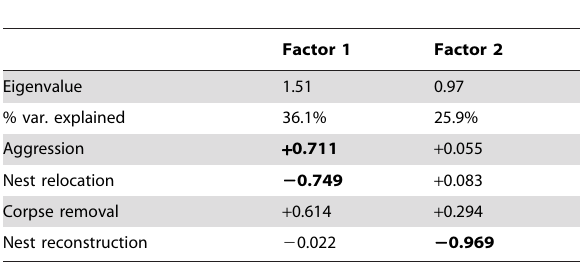
Table 2. Results of the two first factors of the factor analysis performed on mean behaviors of two trials after applying a Z- score transformation and a varimax